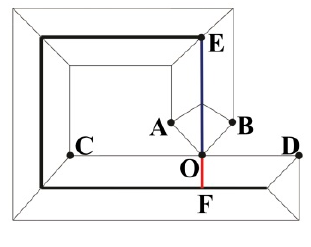
Figure 5. Nodes with degree 2.